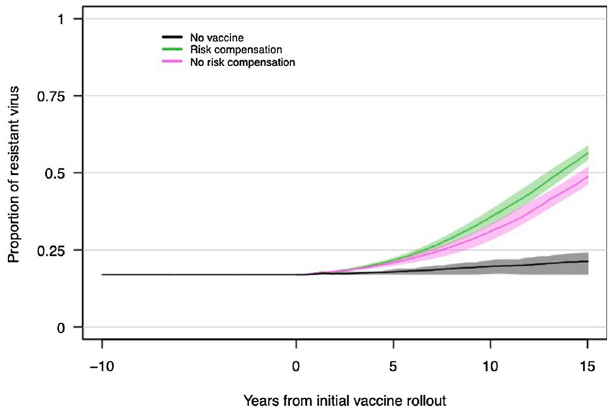
Figure 3. Frequencies of HIV genotypes that are either sensitive or resistant to vaccine induced immune responses, following introduction of a partially effective vaccine (here shown as years from vaccine rollout). The plot shows the mean and 95% credible interval of 64 replicates for each scenario (no vaccine, vaccine with risk compensation, and vaccine without risk compensation). The vaccine scenarios include a vaccine with 60% vaccine efficacy, 83.3% vaccine sensitive virus at vaccine rollout, and 70% population vaccine coverage (50% overall vaccine efficacy at rollout). Risk compensation is modeled as a 30% reduction in condom use among vaccinated individuals.